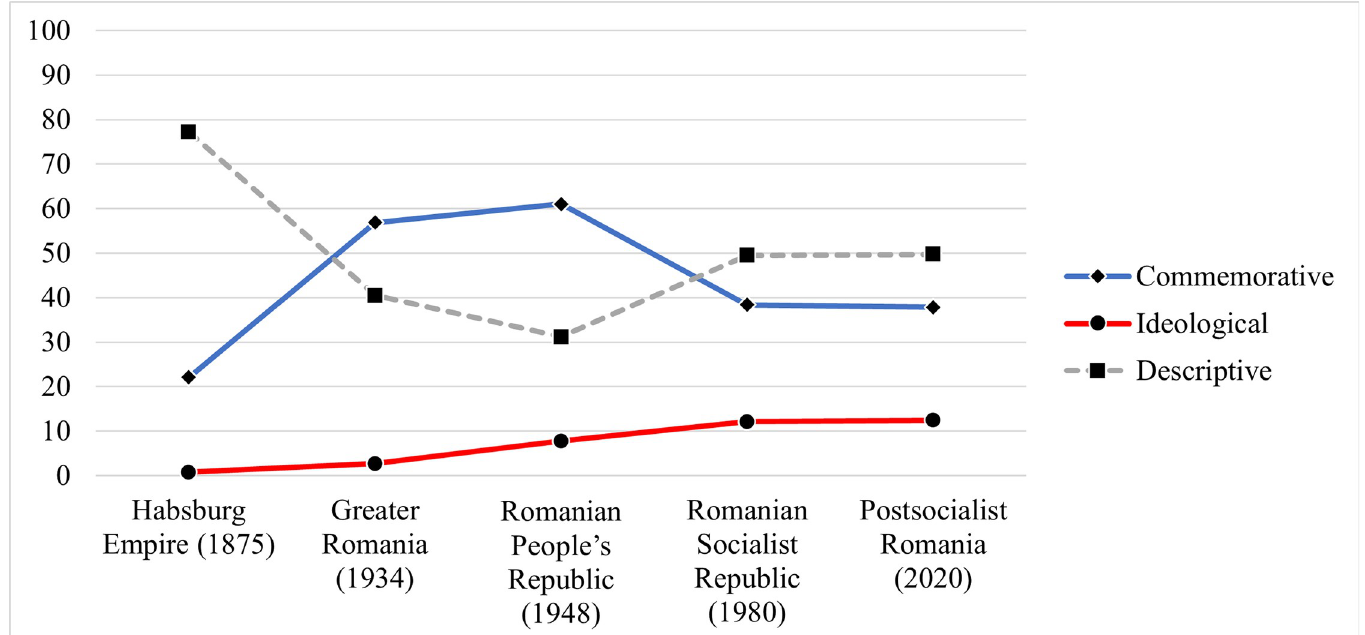
Fig 2. Time series of Sibiu’s street name types.